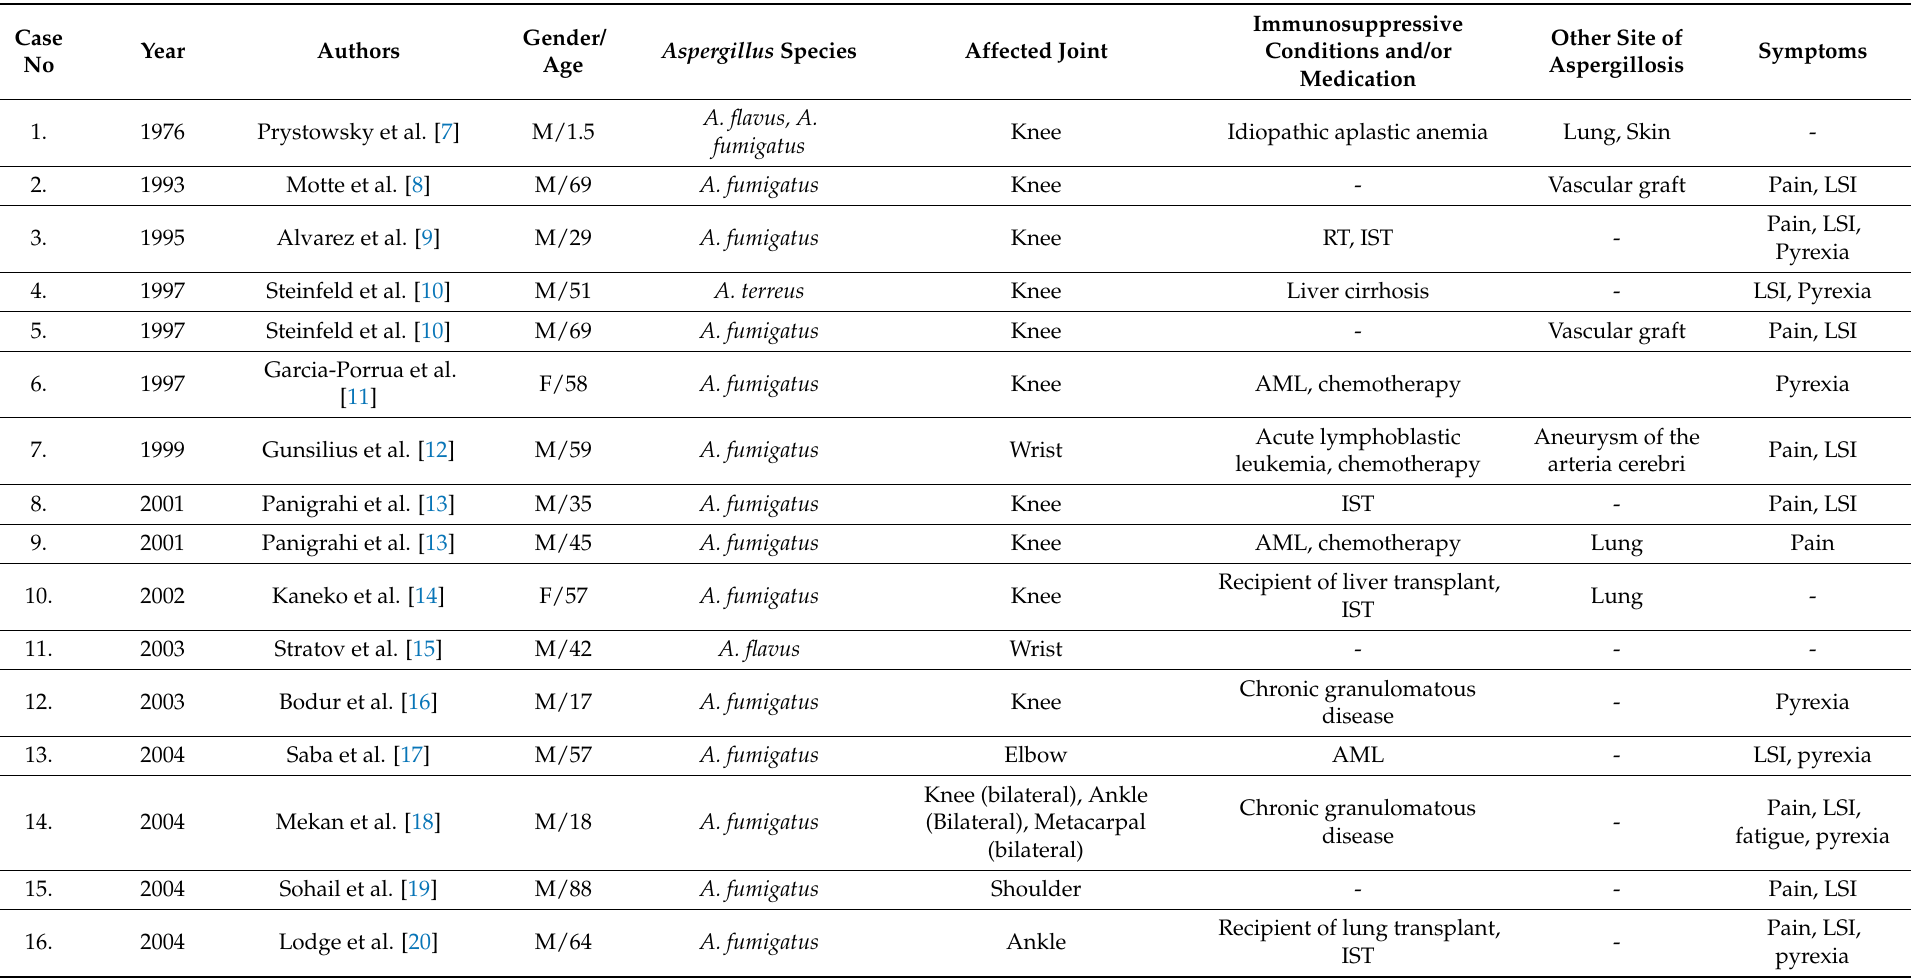
Table 1. Patient’s demographics, responsible fungus, affected joint, immunosuppressive condition and/or medications, other site of Aspergillosis and symptoms. M: male, F: female, RT: recipient of renal transplant, IST: immunosuppressive treatment, AML: acute myelogenous leukemia, DM: diabetes mellitus, LSI: local signs of